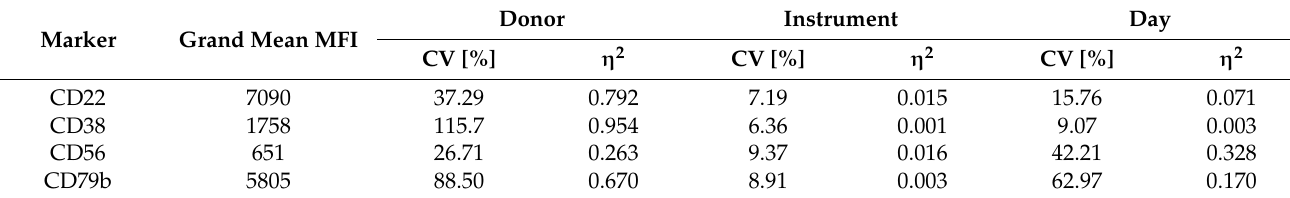
Table 2. Variability of flow cytometric expression analysis based on MFI measurements using PE-conjugated antibodies targeting different markers on cell populations of PB of healthy donors. Coefficients of variation (CV) and their influence on the observed variance based on the effect size ( η 2 ) were determined by ANOVA analysis.